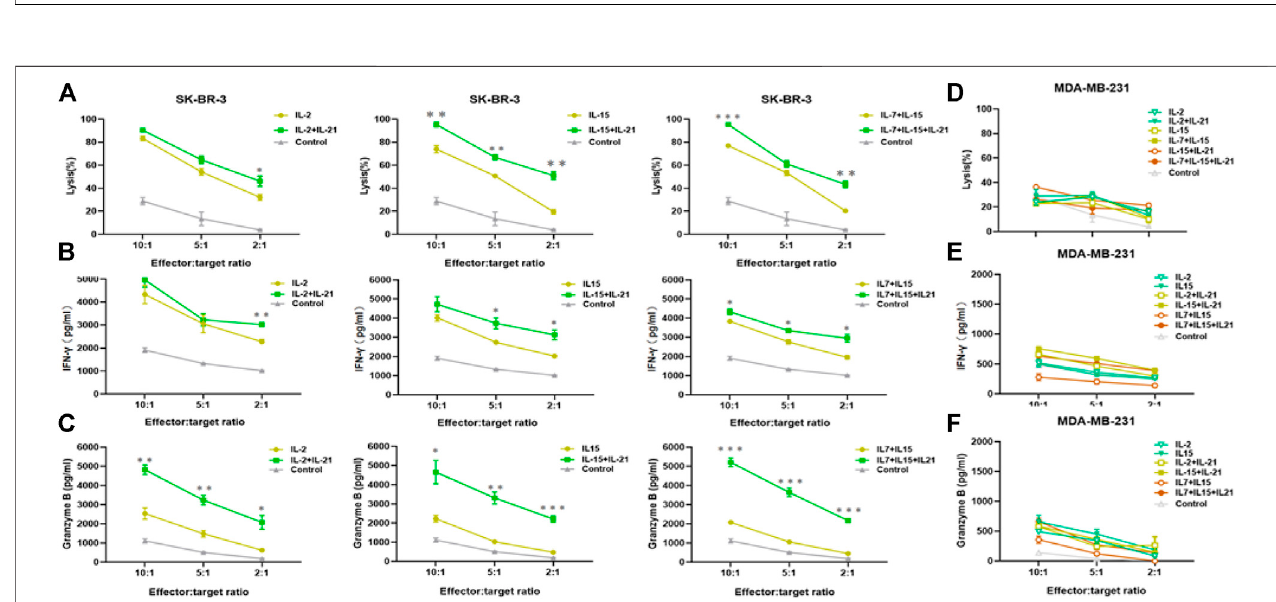
FIGURE 6 | IL-21 augments cytolytic activity of HER-2-speci fi c T cells. (A) Cytotoxicity of HER-2-speci fi c CAR-T cells was evaluated by Calcein AM release assay after co-culture with HER-2-positive SK-BR-3 cells for 6 h at E:T ranging from 10:1 to 2:1. (B,C) Supernatant was collected after 24th co-culture of HER-2 CAR-T cells with SK-BR-3 and assayed for IFN- γ and granzyme B release by ELISA. (D) Cytotoxicity was evaluated by Calcein AM release assay after co-culture with HER-2- negative MDA-MB-231 cell for 6 h at E:F ranging from 10:1 to 2:1. (E,F) Supernatant was collected after 24 h co-culture with MDA-MB-231 cells and assayed for IFN- γ and granzyme B release. Each experiment was performed in triplicate. Mean values were calculated for each group. Stastistical was calculated using two-way Student t test, * p < 0.05, ** p < 0.01, *** p < 0.001.